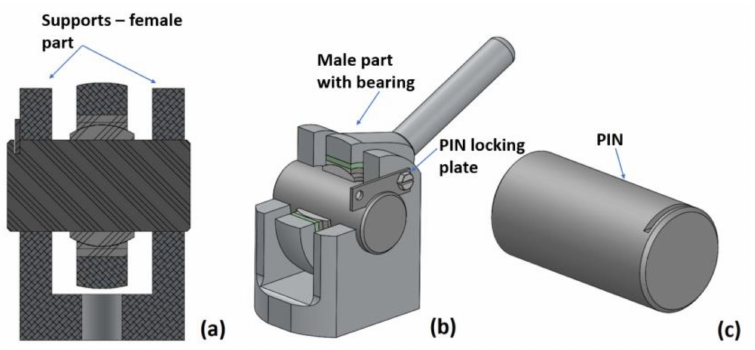
Figure 1. Pin joint illustrated as: ( a ) cross-sectional view, ( b ) isometric view, and ( c ) a cylindrical